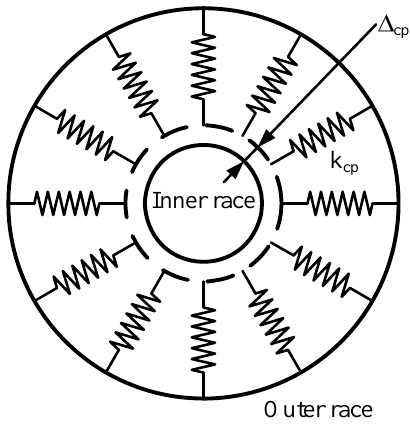
Figure 7: Bearing Model as in Guo and Parker